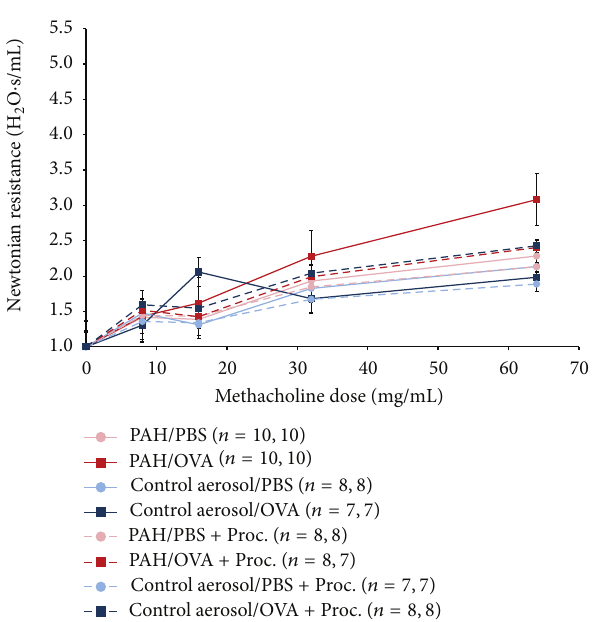
Figure 4: AHR following postnatal PAH exposure in the presence and absence of procaterol (Proc). Newtonian resistance (H 2 O/s/mL) was normalized to value measured following PBS aerosol exposure. Total sample size, followed by sample size for mice that completed highest dose, is listed in parentheses. The PAH/OVA mice showed borderline greater airway resistance when compared to the normal air/OVA group at the 64mg/mL dose ( 𝑃 value = 0.055, two-tailed 𝑡 -test). Clear improvement across experimental groups following administration of procaterol is not evident.